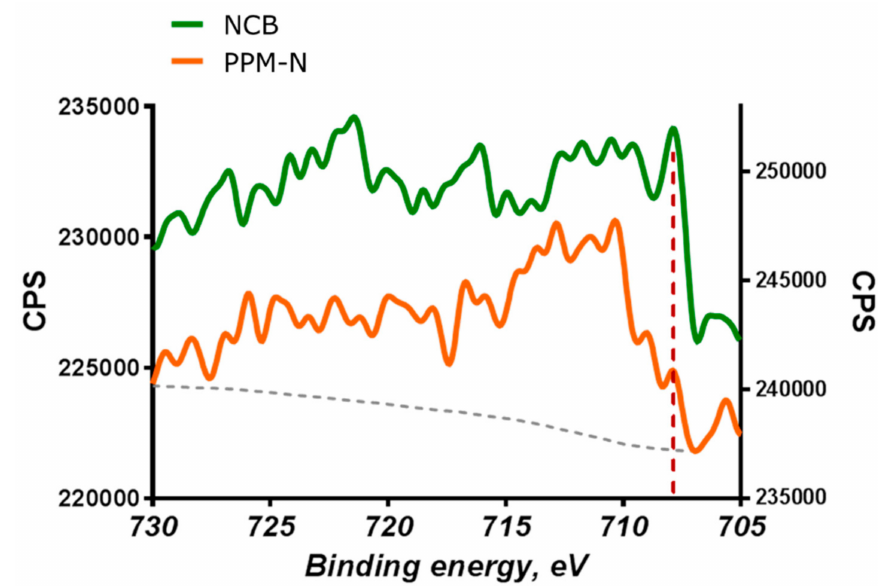
Figure 5. Fe2p HAXPES spectra of NCB and PPM-N. The dot line represents binding energy of metallic Fe: 707 eV.